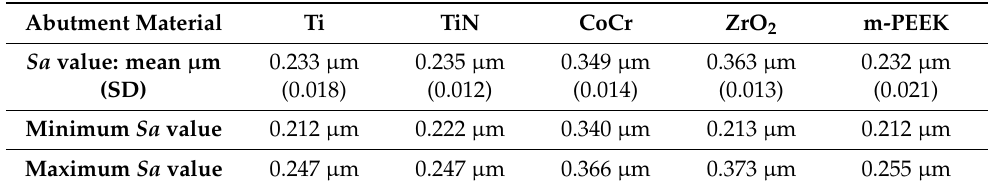
Table 1. Sa mean values and SD for Ti, TiN, CoCr, ZrO 2 , and m-PEEK of the three randomly selected pointes on each side of the